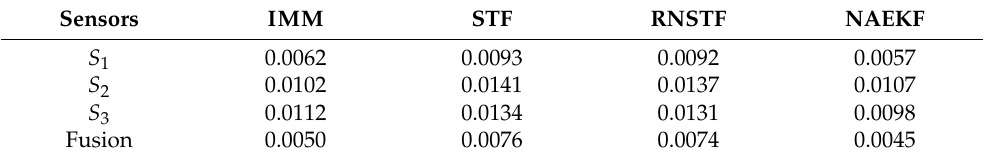
Table 12. Estimation errors of the elevation angle ( ◦ ).